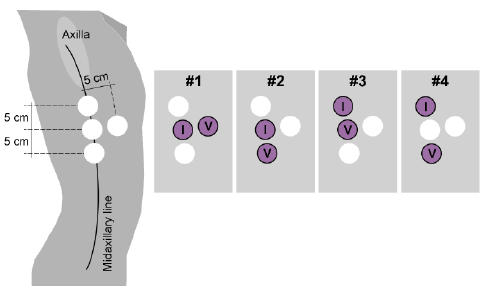
Figure 1. Representation of the tetra-polar electrode configurations. Only the right side is shown because the configurations were symmetric from the midsternal